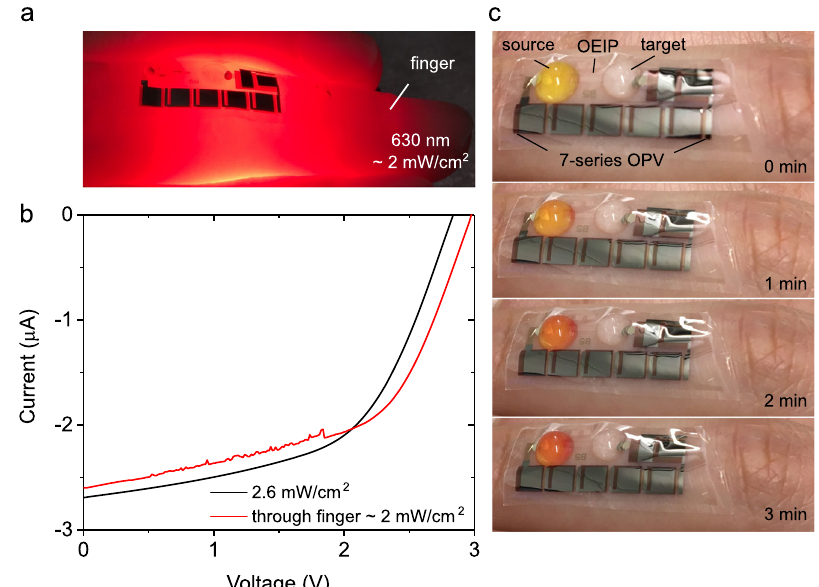
Fig. 3 Through-tissue light actuation of ion transport. a An integrated OEIP with OPV array laminated on the fi nger of the experimenter, with hand placed over a red LED emitting at 630 nm. A light intensity of around 2 mW/cm 2 penetrates through the fi nger. b I( V ) curves measured with the device illuminated through the fi nger, compared with a measurement registered using a similar light intensity. c Validation of successful light-driven H + pumping. 0.1 M HCl is added to the reservoir on the right, while the methyl red pH indicator is put in the left side reservoir. The pH gradient (lower pH on the right) is faintly observable at 1 min. The red light is shone through the fi nger and turned off at 1- min intervals, at which point photographs were